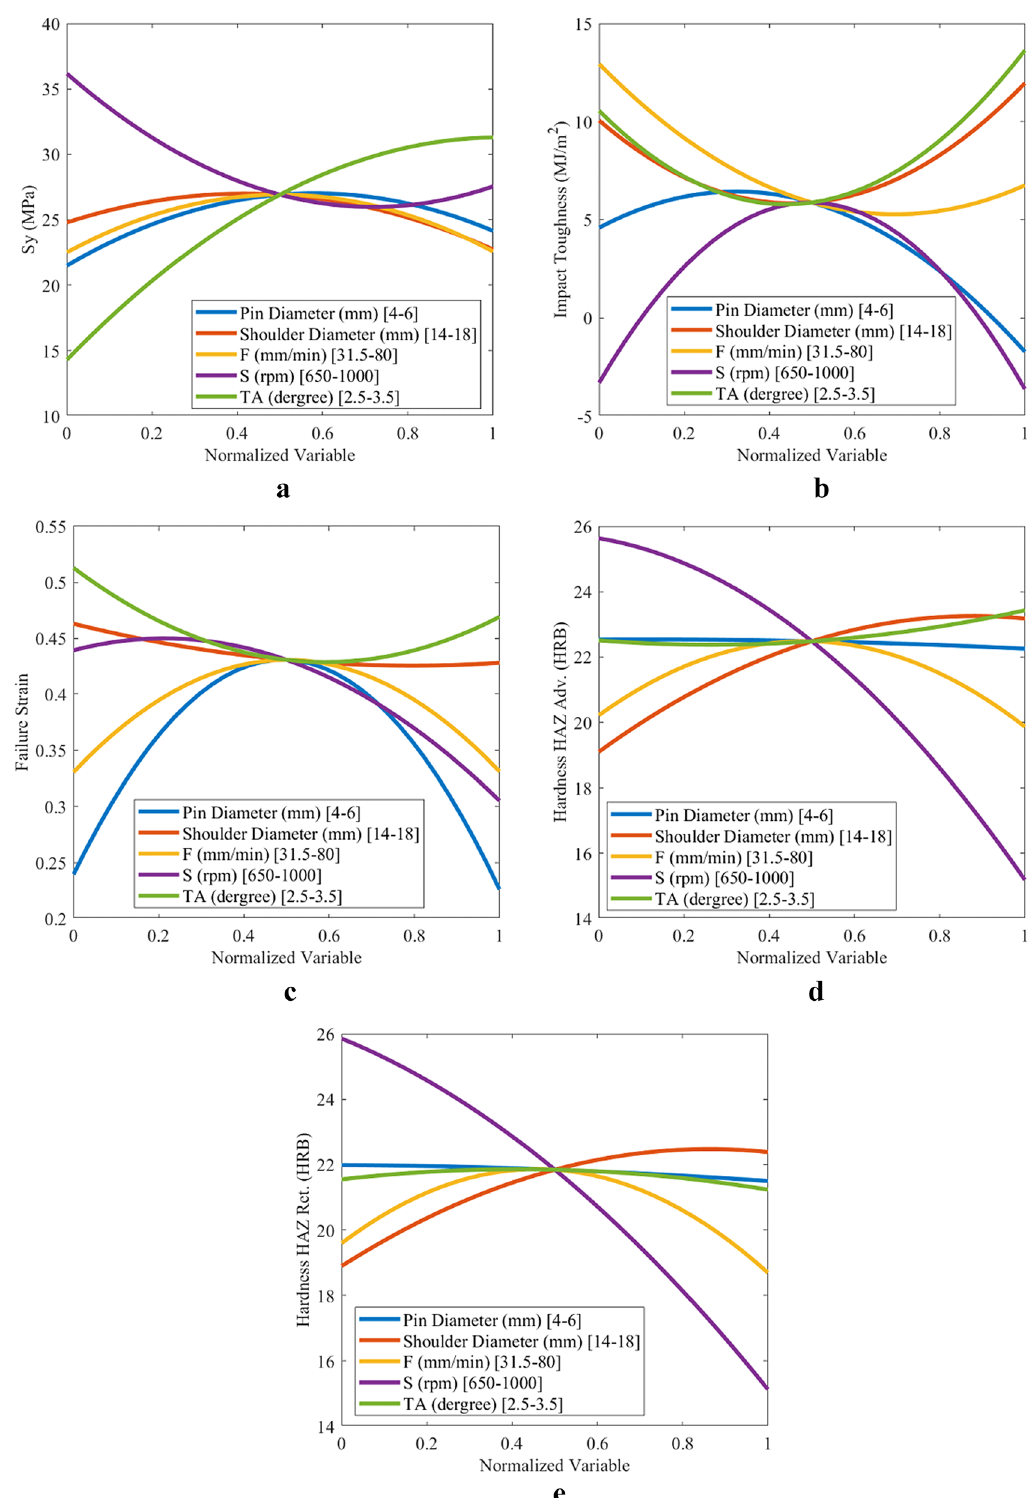
Figure 10. Variations in threaded cylindrical pin objective functions for ( a ) yield strength, ( b ) impact toughness, ( c ) failure strain, ( d ) hardness on HAZ adv., and ( e ) hardness on HAZ